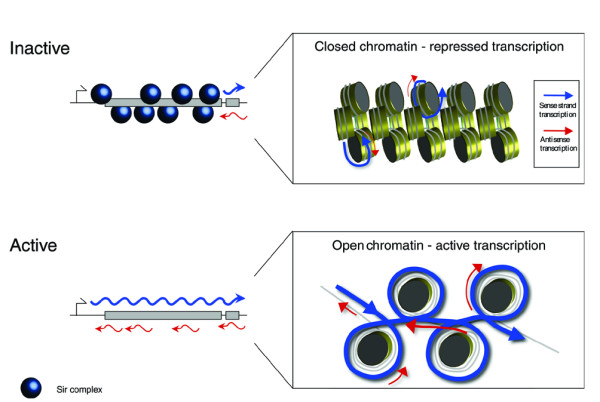
A hypothetical model for antisense transcription from var loci. Sense and antisense RNA at several var loci appear to be coordinately regulated. This may result from the altered chromatin state of the encoding genomic DNA, which is differentially modified between silent and active var loci [3]. Silencing factors such as the SIR complex (indicated by blue spheres) bind to inactive var genes, maintaining the chromatin in a condensed state. In the absence of SIR, the active var assumes a relaxed chromatin conformation that makes the surrounding locus competent for transcription. While a stable transcription complex with appropriate assembly of elongation factors generates abundant sense mRNA of full length, transcription from the opposite strand initiates and quickly terminates to produce fragments of antisense. Simultaneous transcription of the same bases from opposite directions is unviable, but in a population, both transcription events may occur at the same time. A chromatin barrier located in the intron [11] may maintain the first exon in a silencing conformation while allowing relaxation of the second exon, leading to partial 3' transcripts from a subset of otherwise silenced var genes.